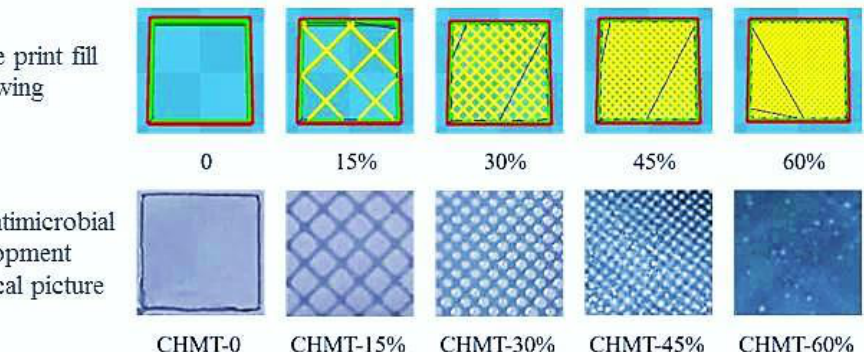
Figure 3. The broad-spectrum bacteriostatic rates of CH, CHT, and CHM under different light treat- ments.